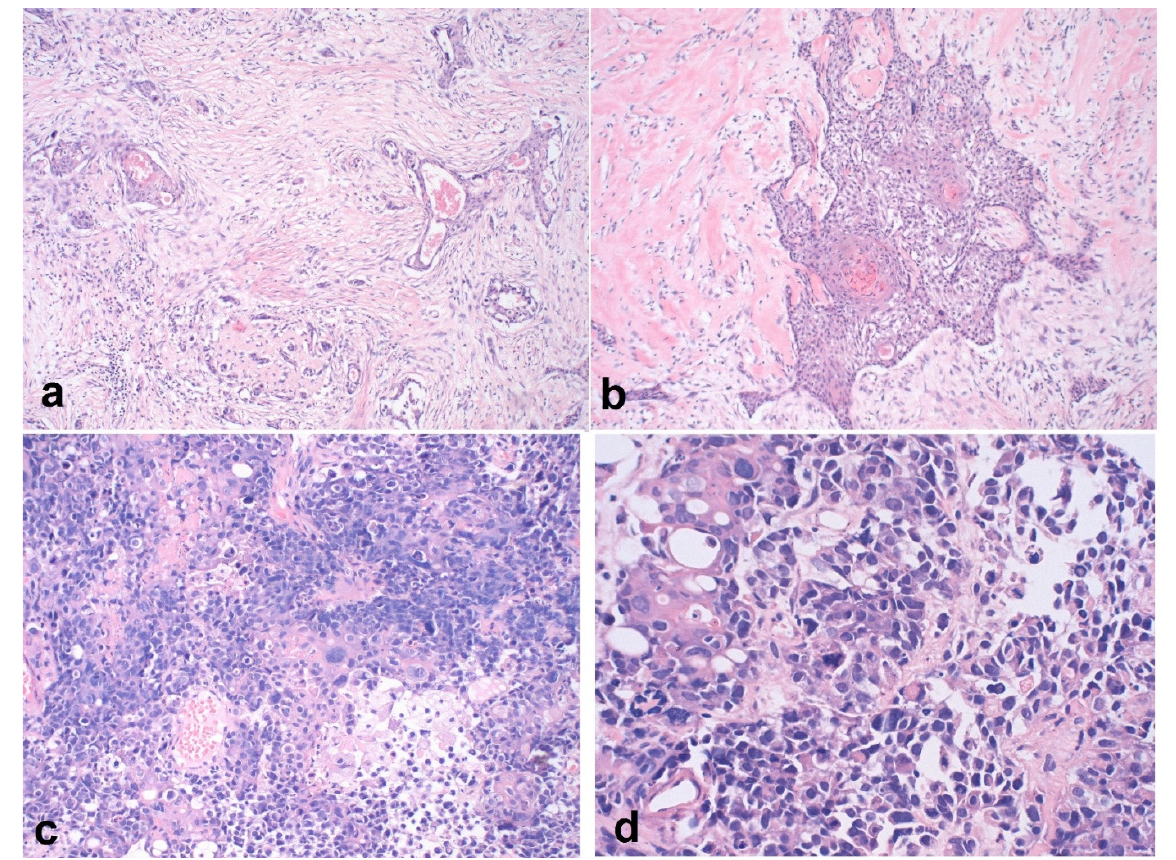
Figure 5. ( a , b ) Low-grade ASC of breast; ( c , d ) high-grade ASC of breast (for illustrative purposes).